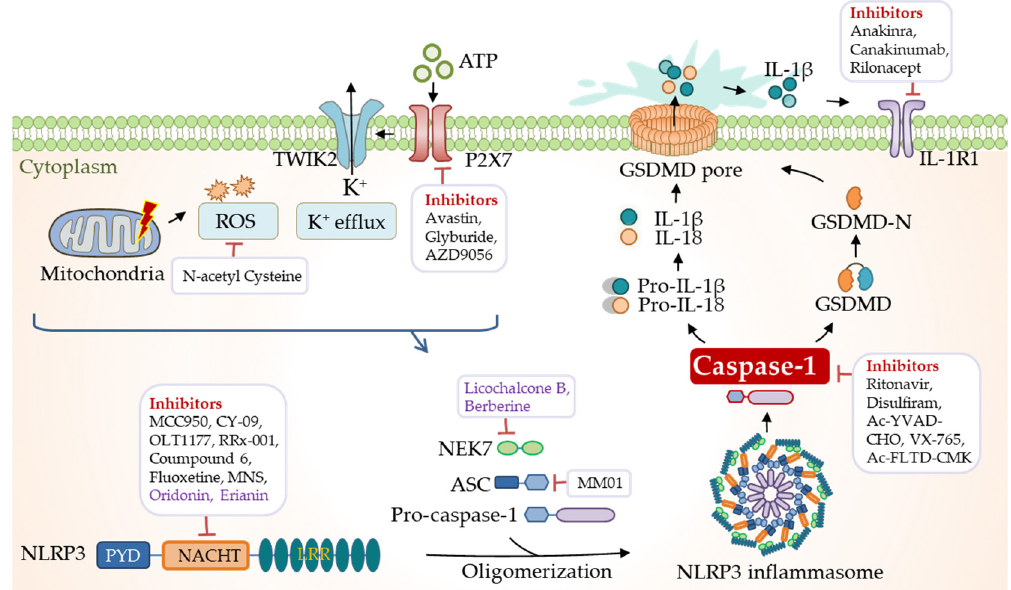
Figure 5. Pharmacological targeting of the NLRP3 inflammasome mechanisms. A wide variety of small synthetic molecules, natural compounds, and antibodies have been developed to target the canonical NLRP3 inflammasome signaling components as research tools and medicines in trials and clinics. Natural, but not synthetic, products are labeled in purple. Table 1. Small molecule inhibitors targeting NLRP3 inflammasome signaling.